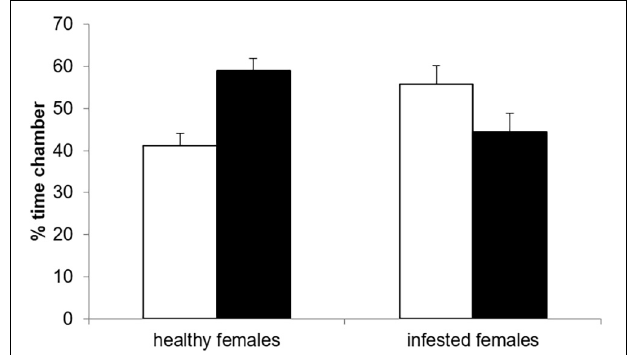
FIGURE 2 | Proportion of time healthy and infested female highveld mole-rats spent in the choice chamber with the odor from a healthy (open bars) or an infested male (solid